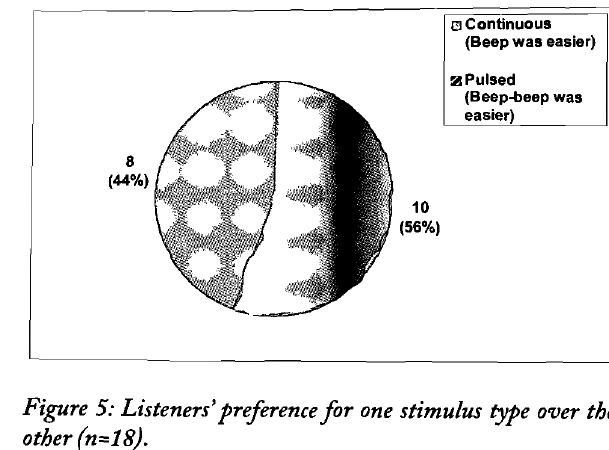
Figure 5: Listeners’ preference fo r one stimulus type over the other